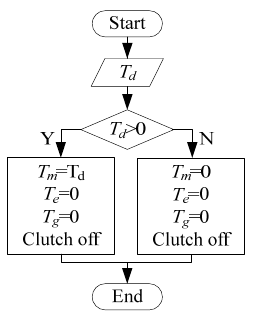
Figure 8. Energy management control strategy in EV mode.